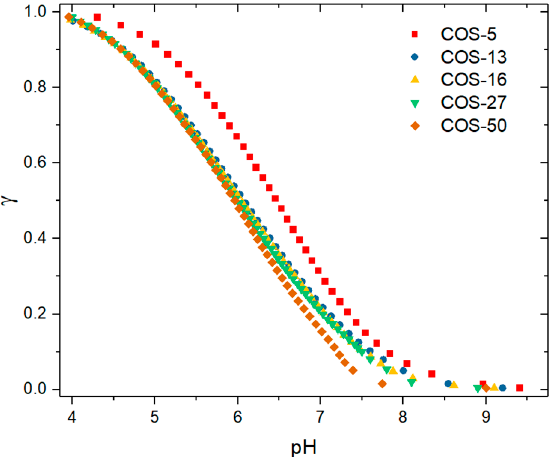
Figure 2. The degree of protonation ( γ ) as function of the pH for COS varying in DP. The concentration of COS is 1 g/L.